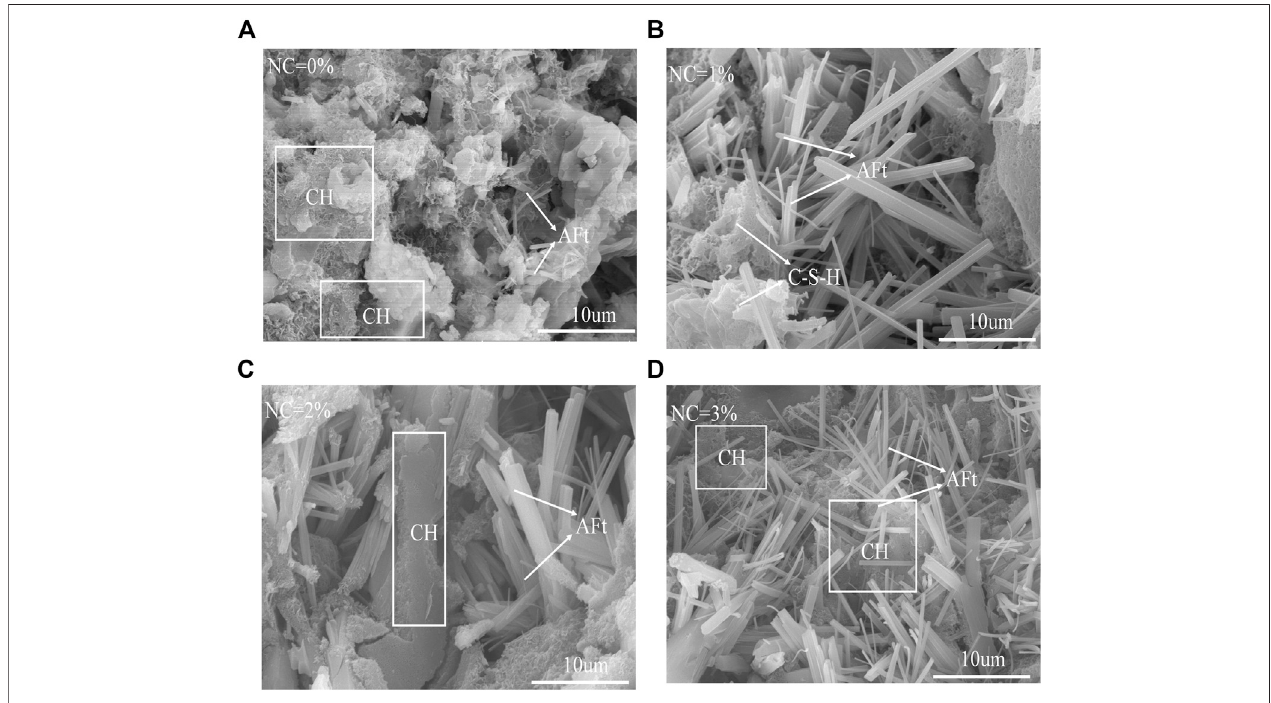
FIGURE 3 | SEM images of microstructure of relative humidity is 90% for curing